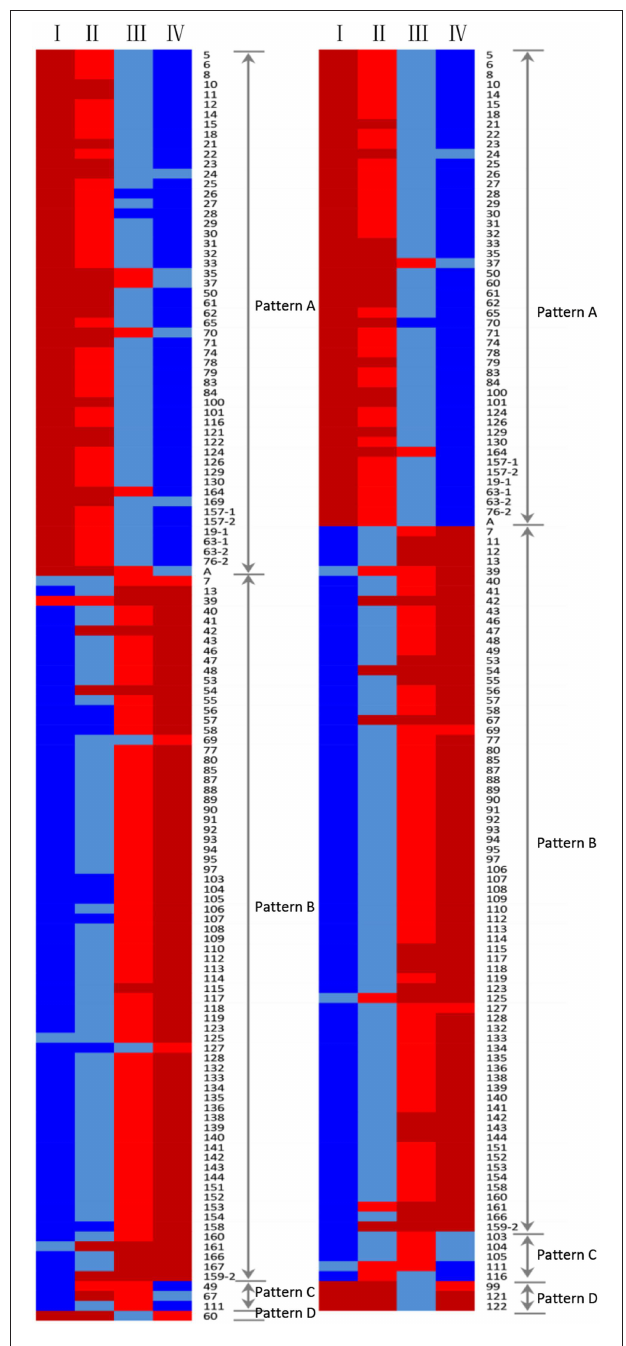
FIGURE 5 | Dynamic analysis of differentially accumulated protein spots during the grain developmental stages (I, II, III, and IV) in Yunong 201 (left) and Yunong 3114 (right). Red color, the lower abundance of protein spots; blue color, the higher abundance of protein spots.